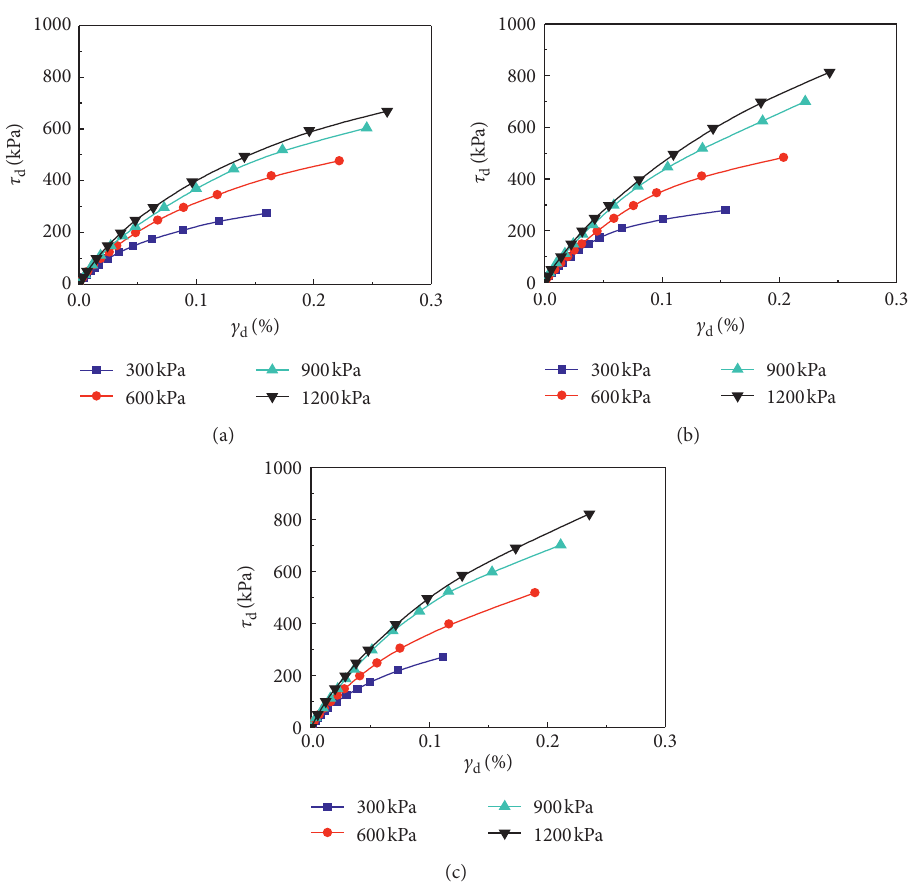
Figure 3: Backbone curve under different LCSG material cementing agent contents. (a) 40kg/m 3 . (b) 60kg/m 3 . (c) 80kg/m 3